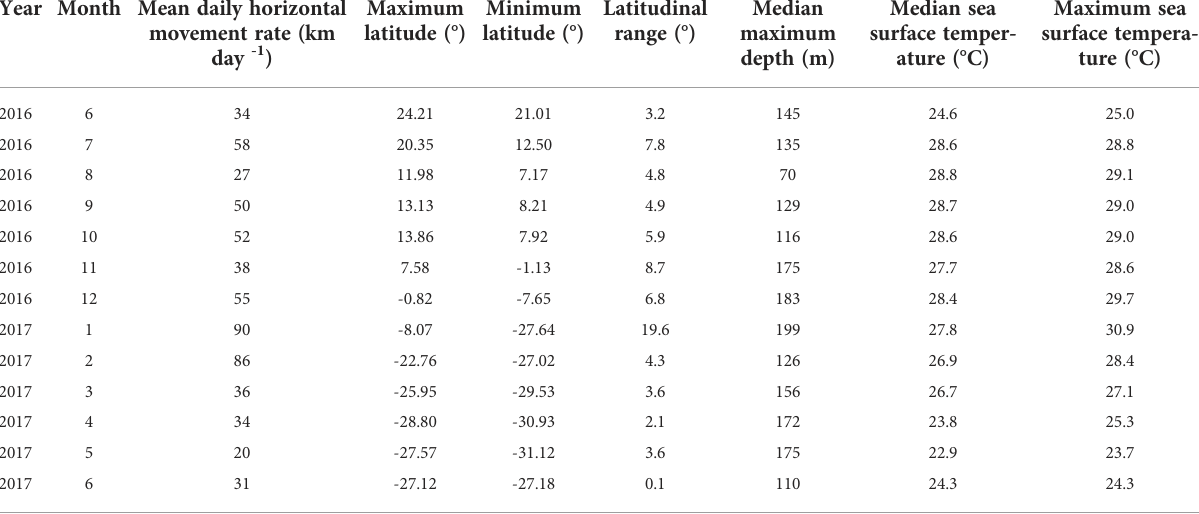
TABLE 4 Monthly daily horizontal movement rate of PG01 in relation to its latitudinal range, maximum depth and sea surface temperature experienced.